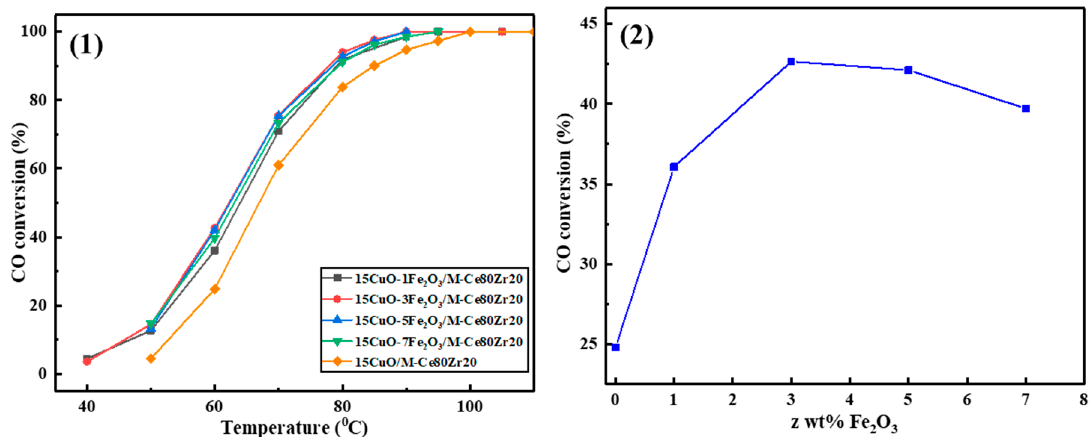
Figure 10. The CO conversion versus reaction temperature over ( 1 ) 15CuO- z Fe 2 O 3 / M-Ce80Zr20 catalysts with different Fe 2 O 3 loading amounts, ( 2 ) the CO conversion versus the loading amounts of Fe 2 O 3 ( z %)) over 15CuO- z Fe 2 O 3 / M-Ce80Zr20 catalysts; reaction conditions: 1%CO-20%O 2 -N 2 balance, GHSV = 12000 mL / (g · h), 1 atm.